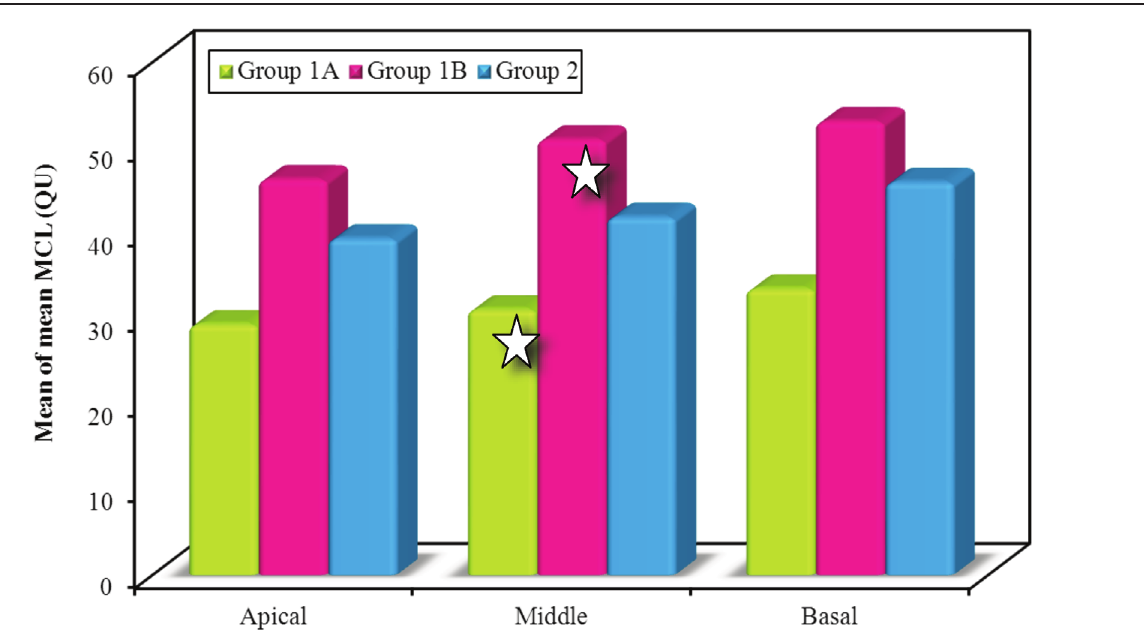
Mean MCL for the electrode regions in the three groups.